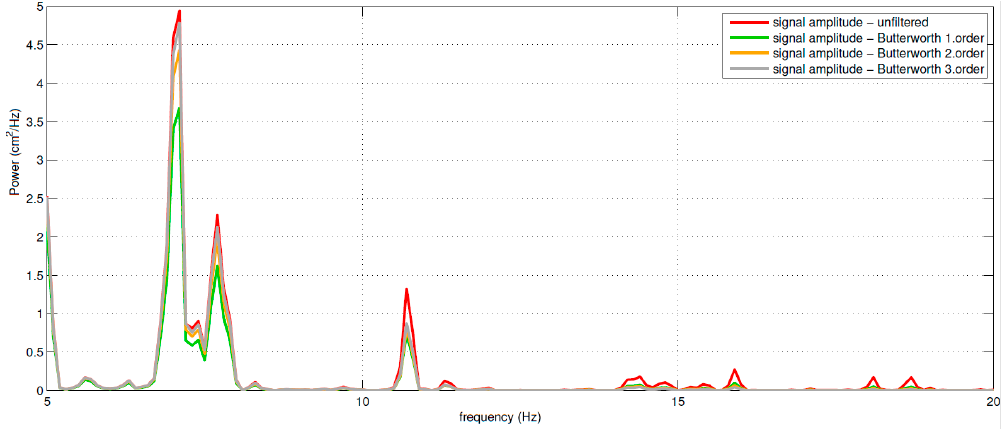
Figure 3. Representation of the signal frequency components and the associated effect, without filter (blue) and with the Butterworth filters in different orders.